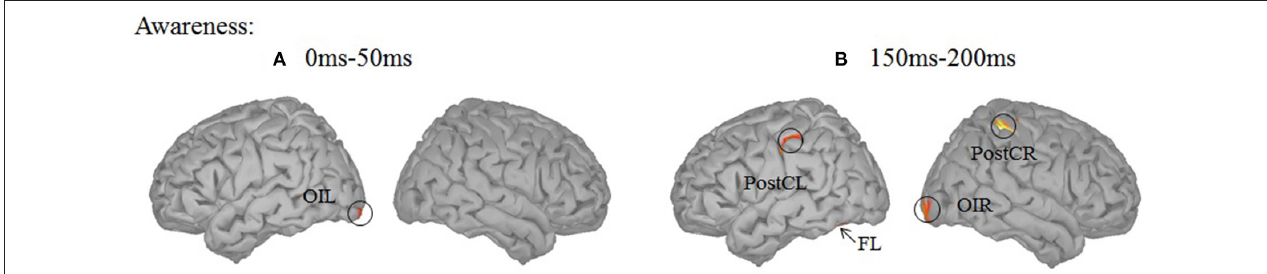
FIGURE 5 | Source localization using a more liberal threshold. (A) Contrast between the aware and unaware conditions in the 0–50ms time-window. A significant source was observed in the left inferior occipital cortex (OIL). (B) Contrast between the aware and unaware conditions in the 150–200ms time-window. Significant sources were observed in the bilateral post-central gyrus (PostC), left inferior occipital cortex (OIL) and left fusiform gyrus (FL).